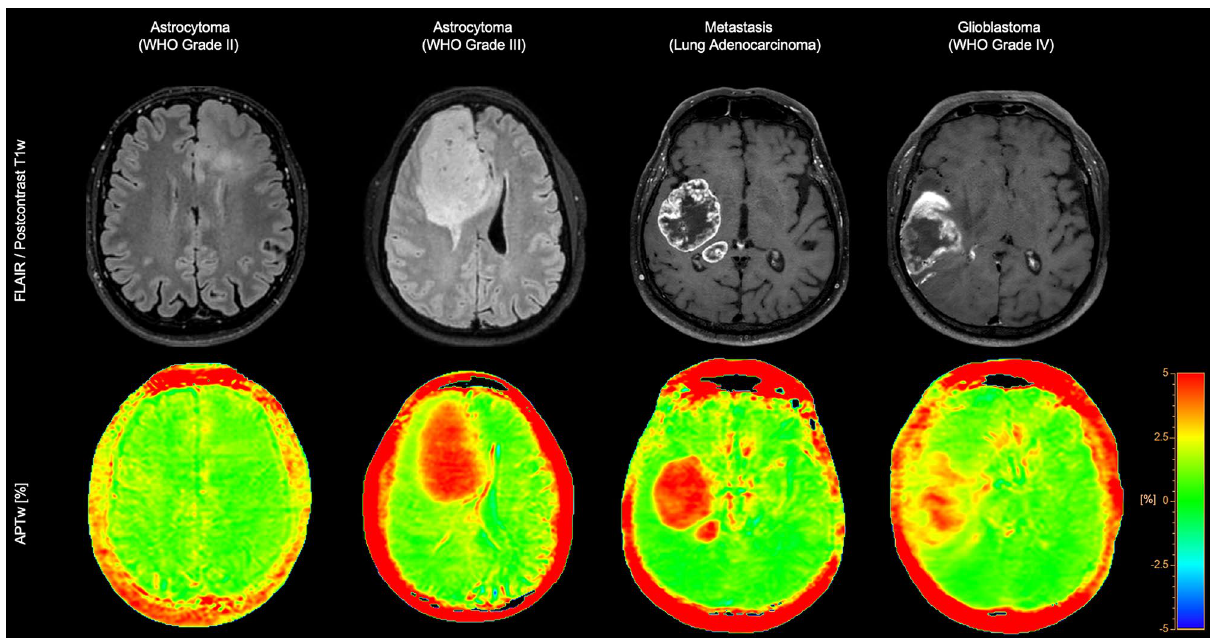
Figure 1. Representative image examples of 4 patients who presented with different neoplasms. FLAIR or T1w postcontrast images are provided in the top row, while the corresponding APTw images are shown in the bottom